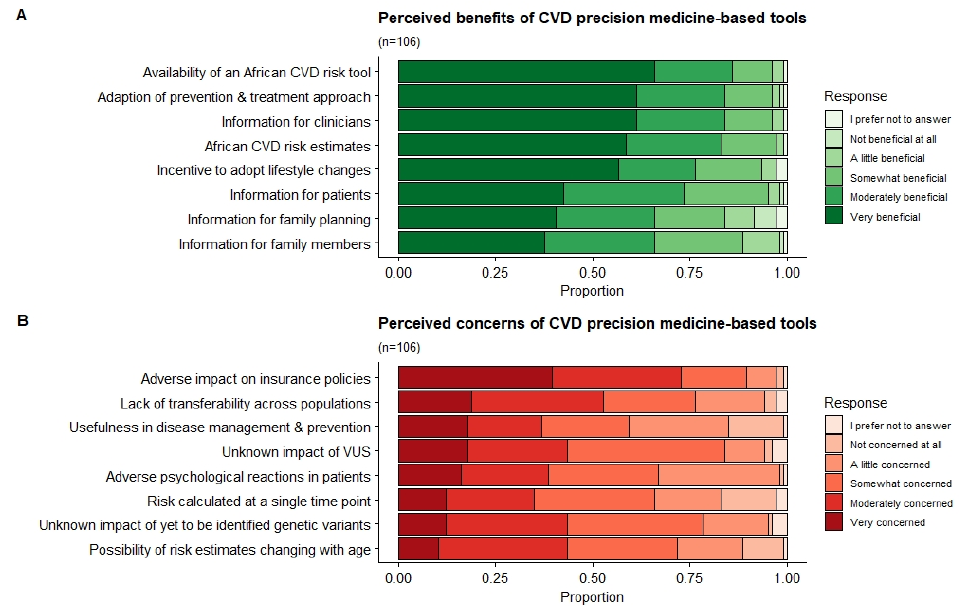
Figure 3. Perceived benefits and concerns of a PM-based CVD risk stratification. The distribution of the clinicians’ responses relating to the perceived benefits ( A ) and concerns ( B ) of a PM-based CVD risk stratification in the South African public setting.